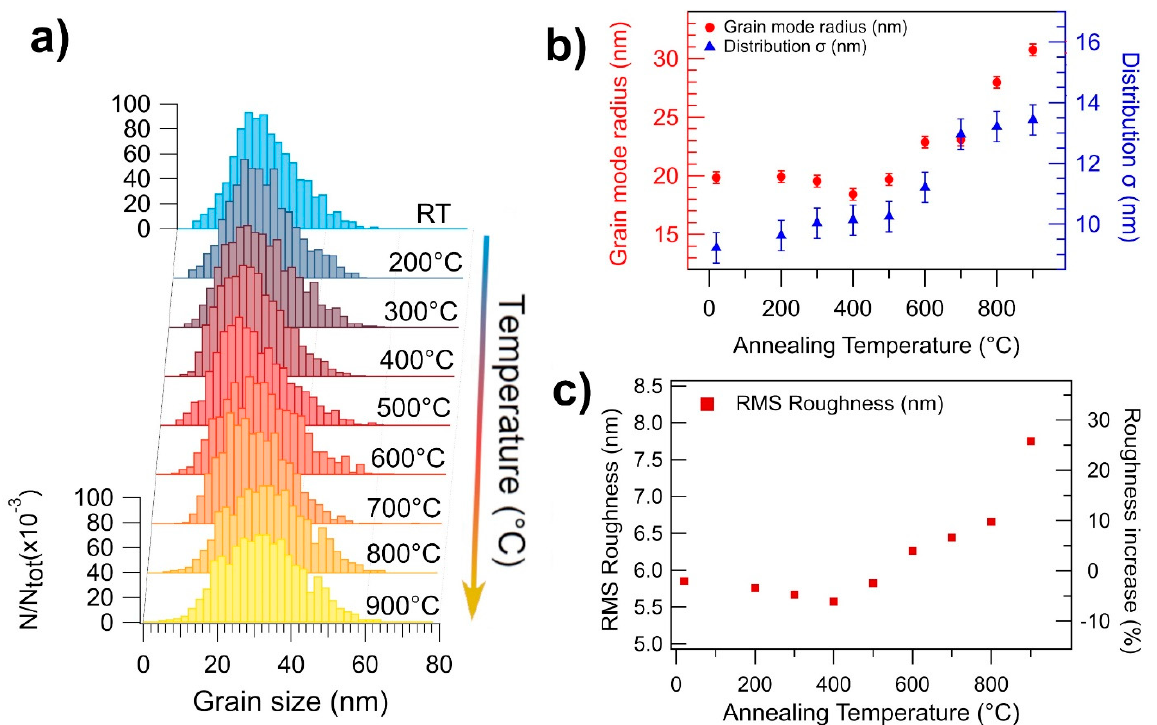
Figure 2. ( a ) Evolution of the GSD of the Ag/TiO 2 (Ag/Ti 50–50) film on silica as a function of the annealing temperature. ( b ) Evolution of the mode (red dots, left axis) and standard deviation (blue dots, right axis) of the GSD as a function of the annealing temperature. ( c ) RMS roughness of the Ag/TiO 2 (Ag/Ti 50–50) film on silica as a function of the annealing temperature. The percentage increase in RMS roughness, compared to the as-deposited film, is reported on the right axis referring to the same data.